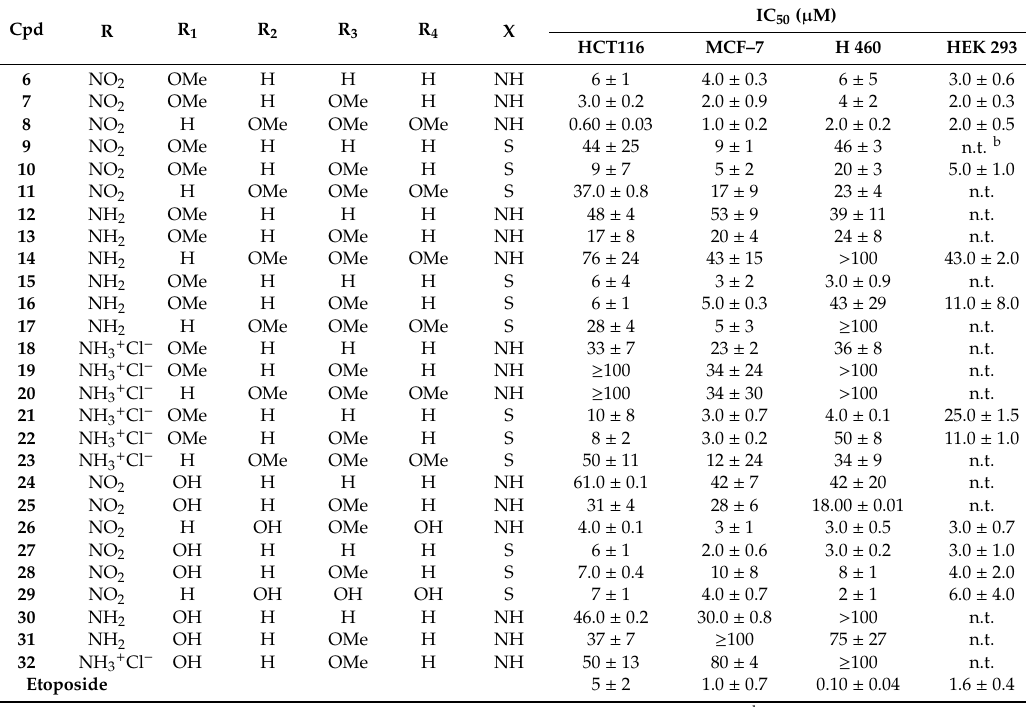
Table 1. IC 50 a values for tested compounds (in µ